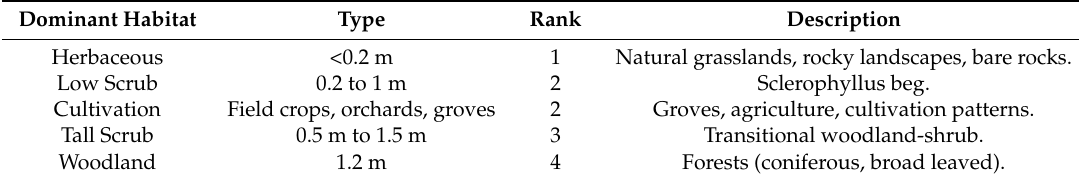
Table 5. Dominant habitat ranking system of each landscape type.